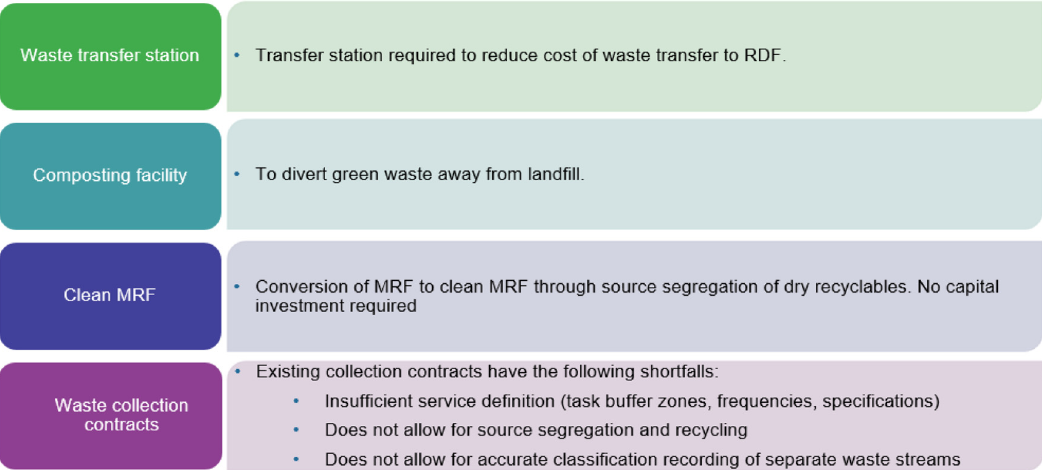
Fig. 10. Recommended that a speci fi c infrastructure strategy